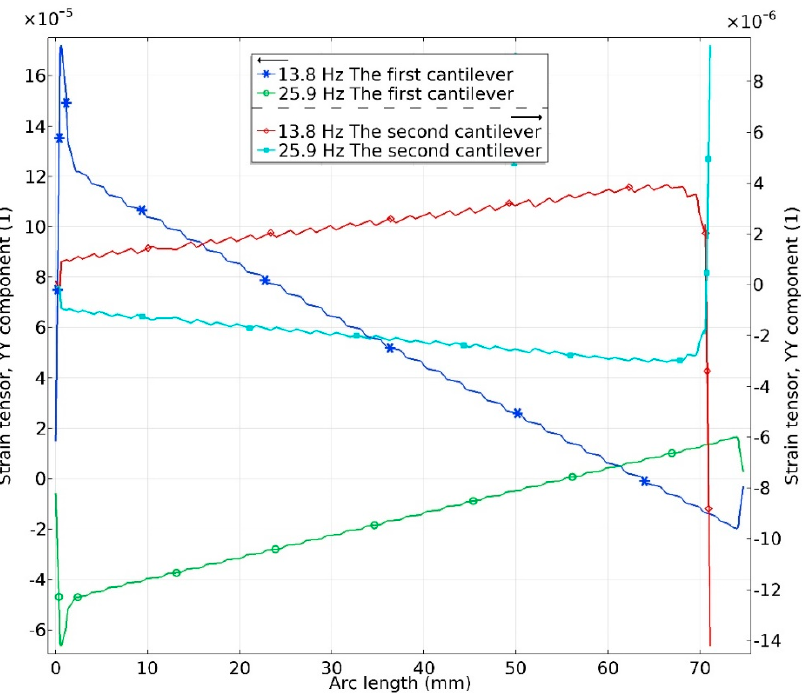
Figure 11. Bending strain characteristics at resonant frequencies during excitation in z direction.